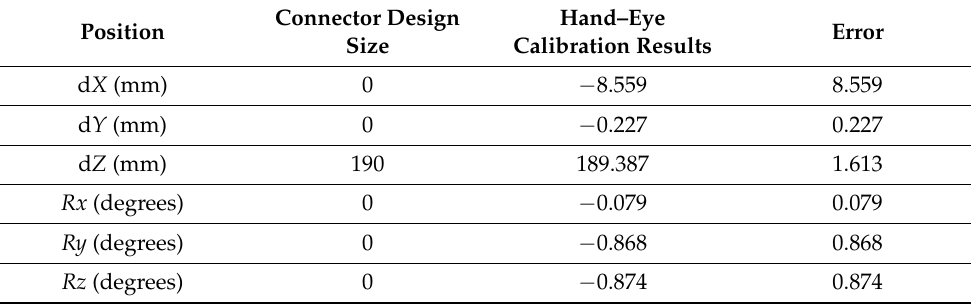
Table 3. Hand–eye calibration results and